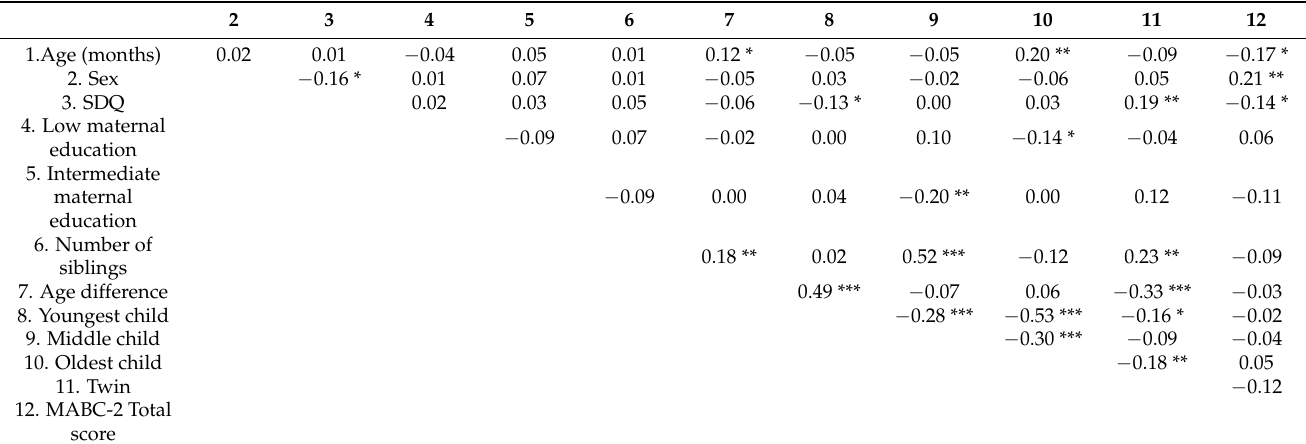
Table 2. Bivariate correlation matrix for the key and confounding